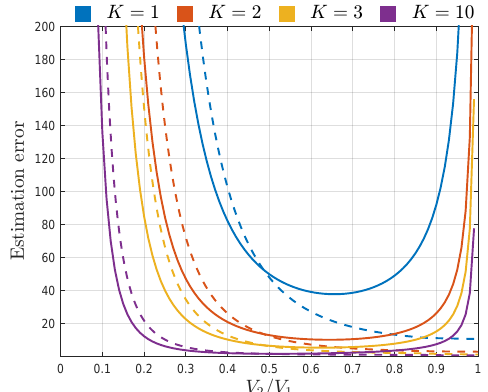
(cid:112) AsV Γ N / ( V 2 / V 1 ) 2 of ˆ Γ (solid line) and Figure 6. ent values of K